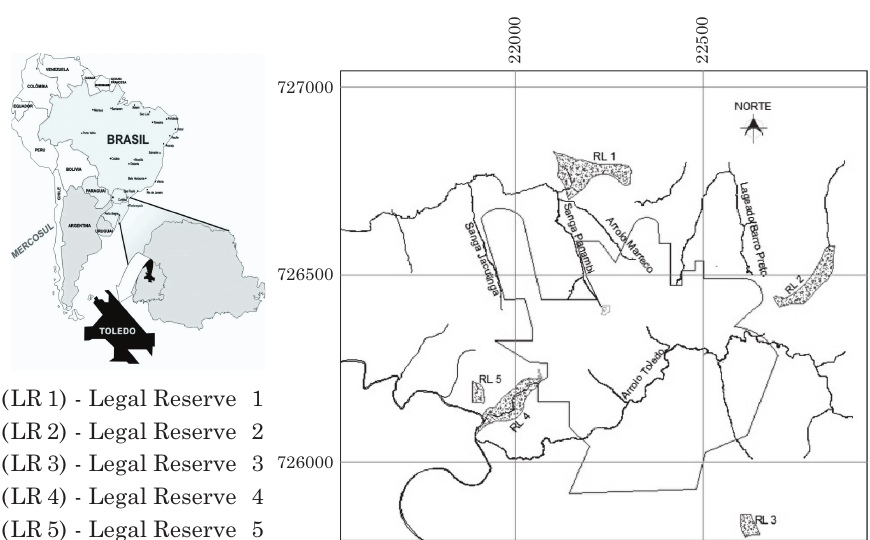
Figure 1. Geographical location of the study area (a) South America, Brazil, Paraná, Toledo; and (b) urban perimeter and location of legal reserves.